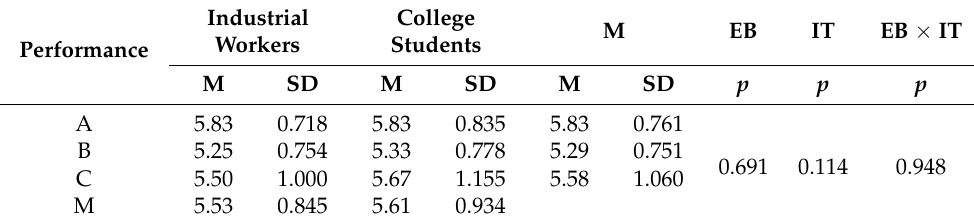
Table 9. Descriptive statistics and two-way ANOVA on performance by